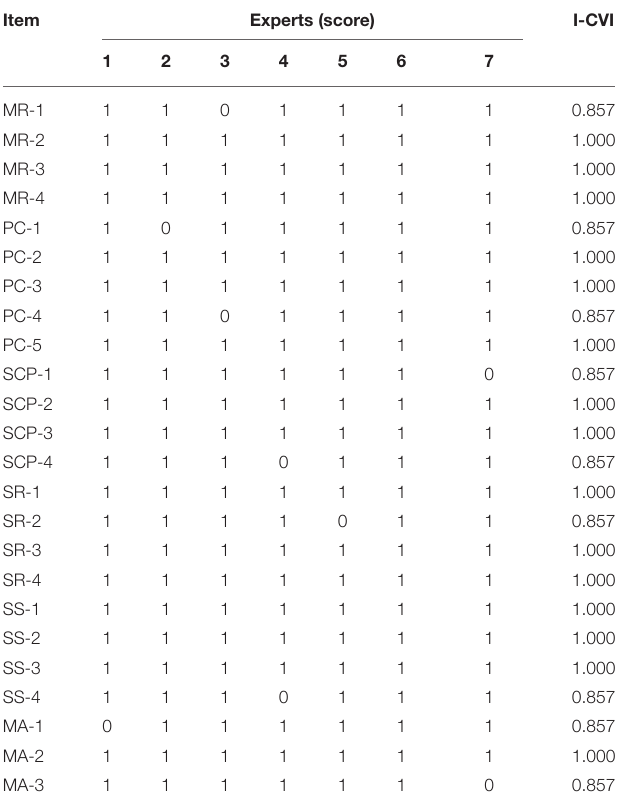
TABLE 4 | Content validity analysis for Chinese version of the